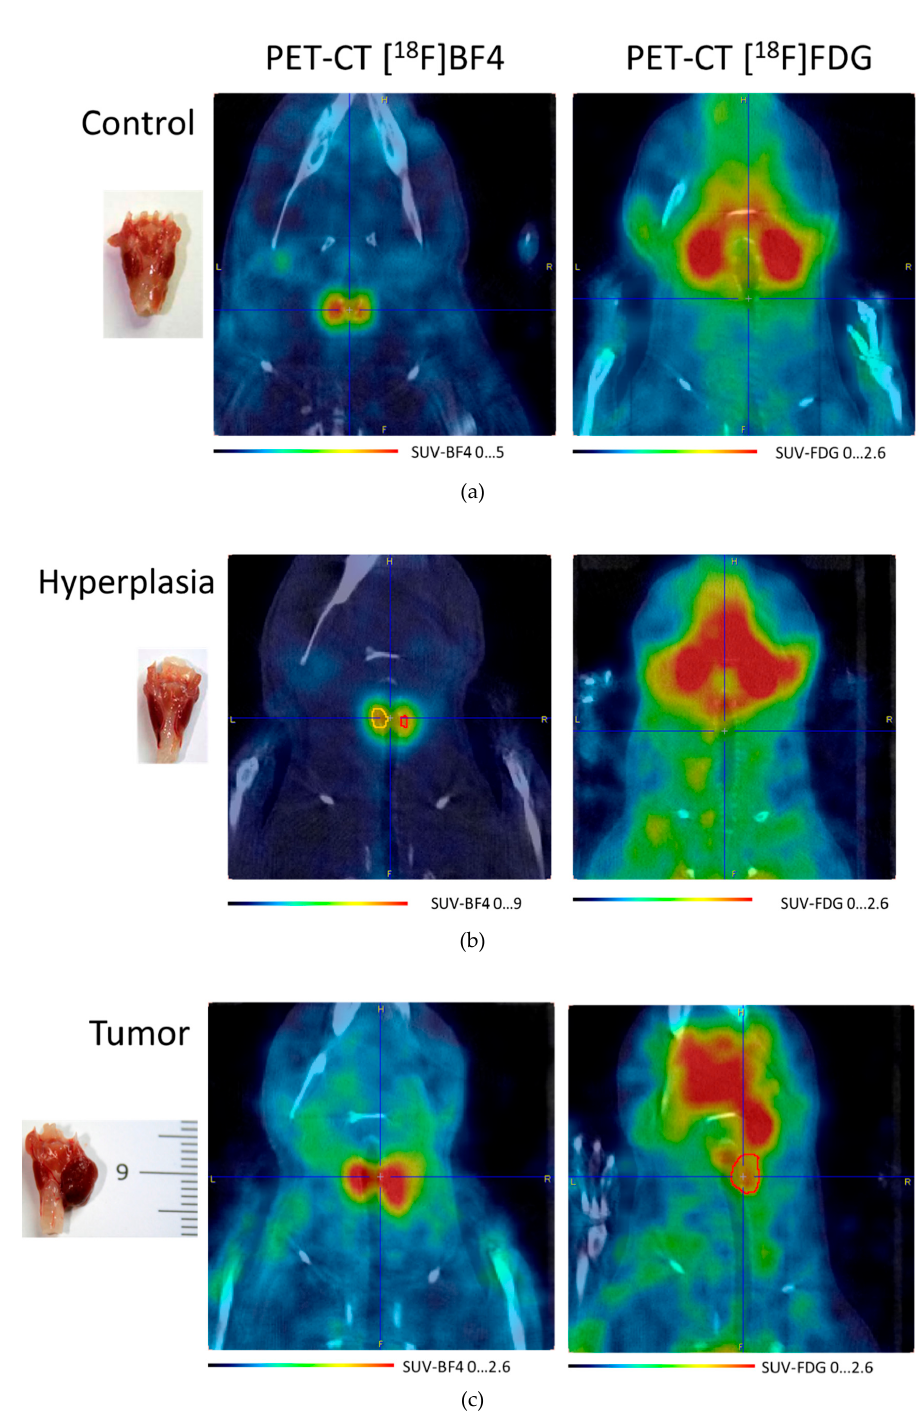
Figure 2. Dorsal view of the thyroid gland. PET-CT in vivo images obtained using [ 18 F]NaBF 4 ([ 18 F]BF4) and [ 18 F]fluorodeoxyglucose ([ 18 F]FDG). Blue cross centered in the thyroid area. ( a ) Control animal. ( b ) Hyperplastic thyroid gland. The volumes of yellow and red show the thyroid gland, which appears to be the same size in the PET image, with a resolution of 2.3 mm. Pay attention to the uptake of the FDG in the annular muscle, the front to the blue cross. ( c ) Tumor in the thyroid gland. Red: volume of interest (VOI) shows the outline of the tumor for the SUV max 1.7 ... 2.4. [ 18 F]BF4) and [ 18 F]FDG images were taken within eight days for each animal. The point of high metabolism of the anterior-internal FDG close to the blue cross is the annular muscle that opens the larynx. On the left, tumor scale in mm. PET / CT DICOM image files are available as Supplementary Material S1 and as reference